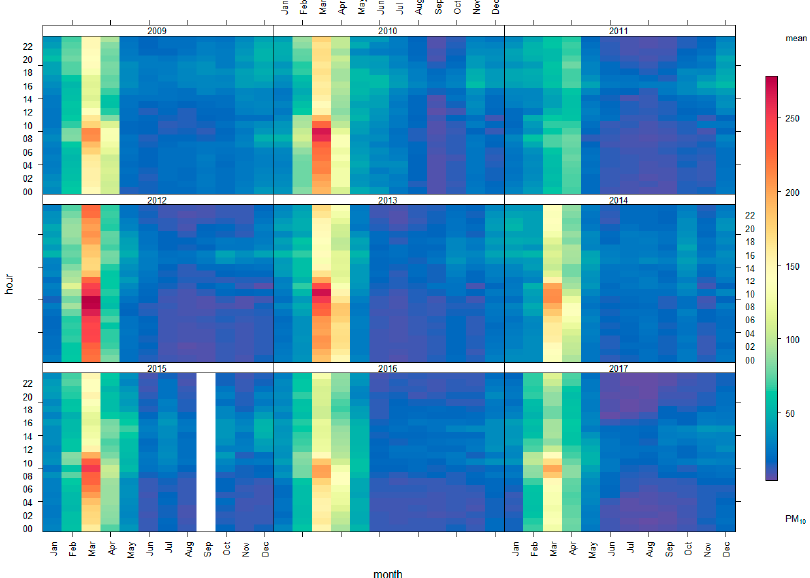
Figure 7. Variations in PM 10 concentrations within each year, by hour and month.